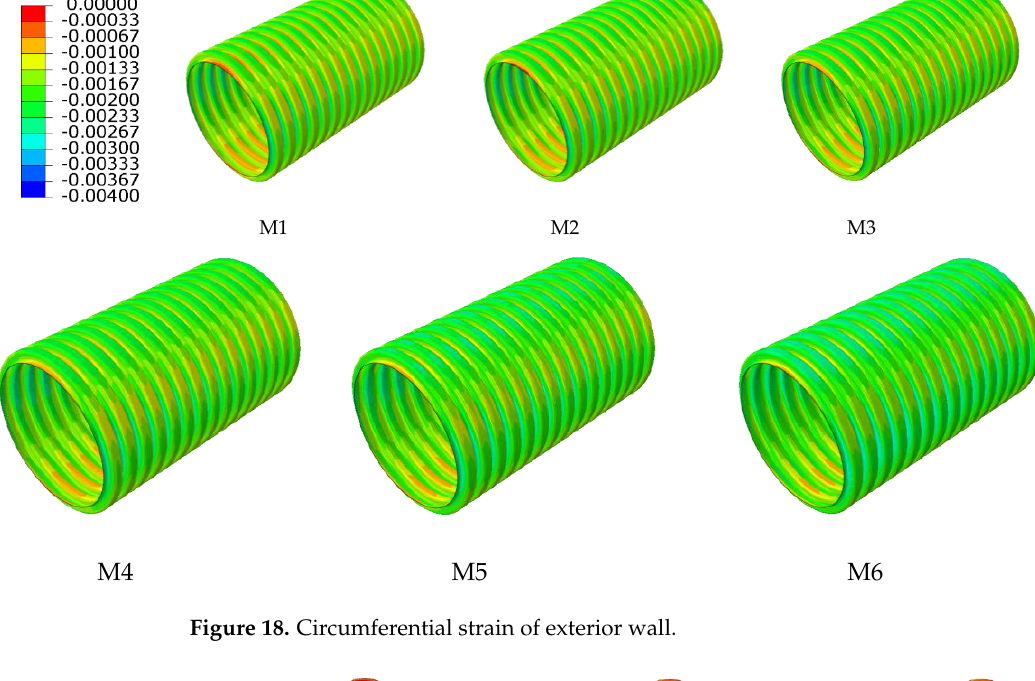
Figure 18. Circumferential strain of exterior wall.